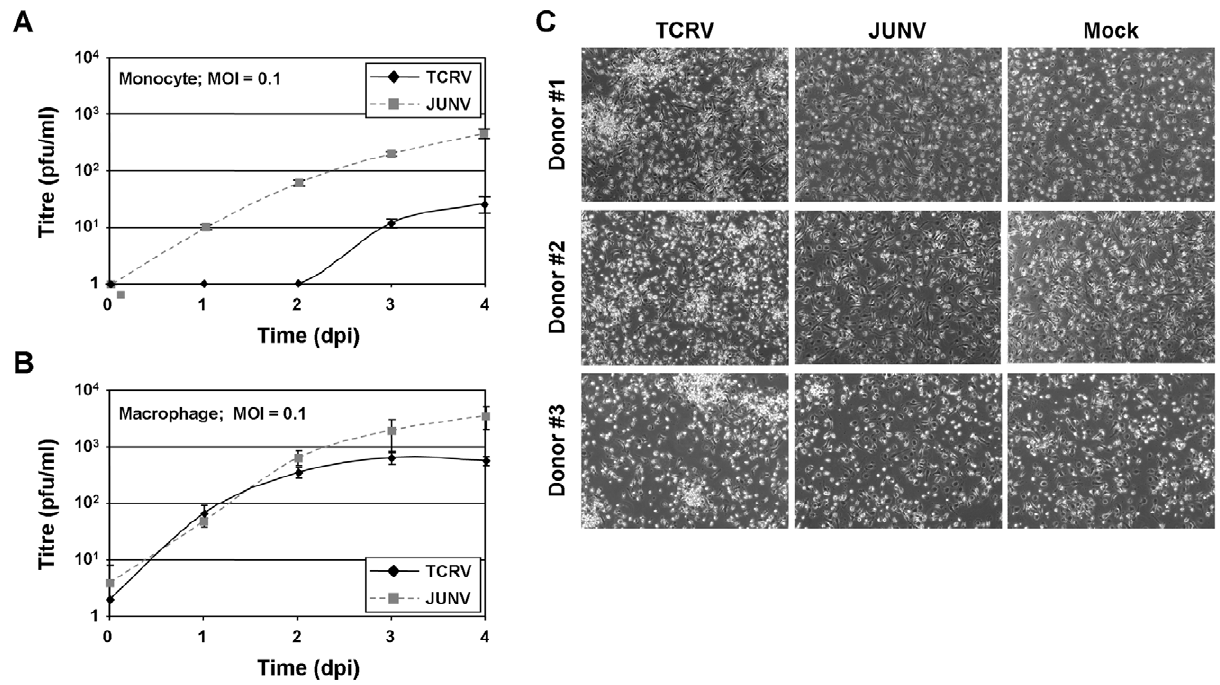
Figure 2. Comparison of virus titre and CPE production during infection of primary human monocytes and macrophages. Growth kinetics of TCRV and JUNV in (A) primary human monocytes and (B) primary human macrophages. Primary human monocytes and macrophages were isolated by adherence of peripheral blood mononuclear cell fractions in 6-well plates with subsequent maturation for either 1 (monocyte) or 7 (macrophage) days. Subsequently, monocyte (upper panel) and macrophage (lower panel) populations were infected at an MOI of 0.1 with either TCRV or JUNV. Cell culture supernatants were harvest immediately after infection and every 24 h thereafter for a period of 5 days. Virus titres in these supernatants were determined by plaque assay. (C) Cytopathic effect during infection of primary human monocytes with TCRV and JUNV. The cells from which supernatants were collected for analysis in (A) were analysed by light microscopy for the formation of cytopathic effect in comparison to mock infected cells 4 days after